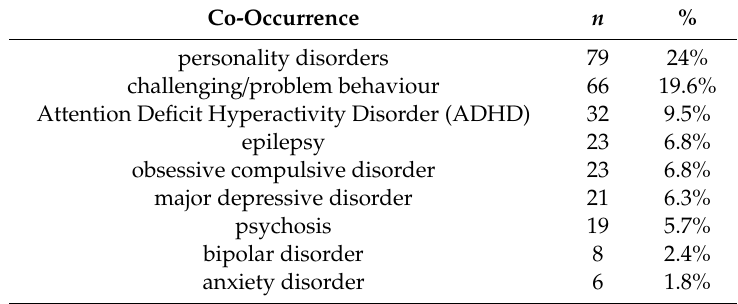
Table 2. Psychopathological and neurological co-occurrence in the study participants with